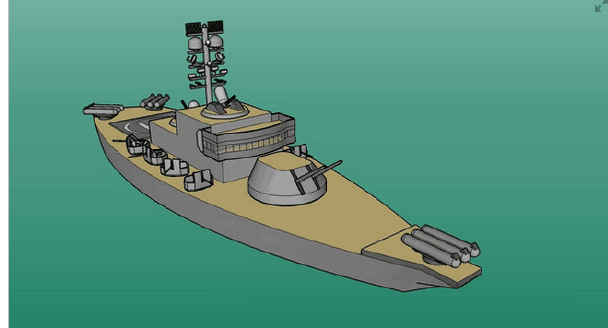
Figure 11. Ship target of interest.